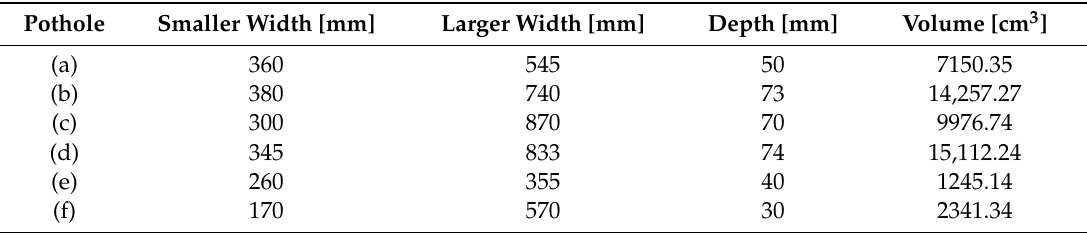
Table 6. Dimensions of potholes measured in terrain